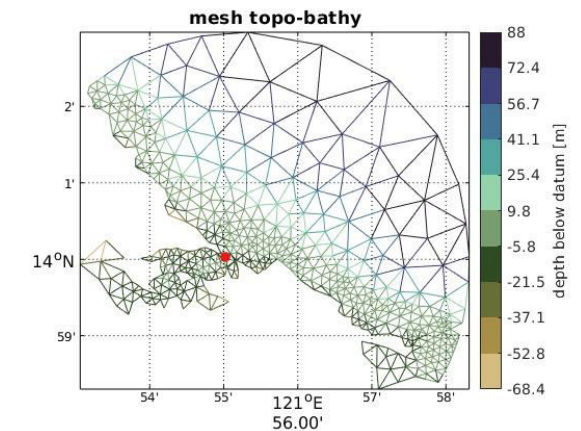
Figure 9 . Crenulate bay reclamation plan. Zoning is similar to the LGU reclamation plan (see Figure 7). Figure 10 . Unstructured mesh for crenulate bay reclamation plan generated using OceanMesh2D, with visualization of topography and bathymetry. The location of hypothetical land reclamation is marked